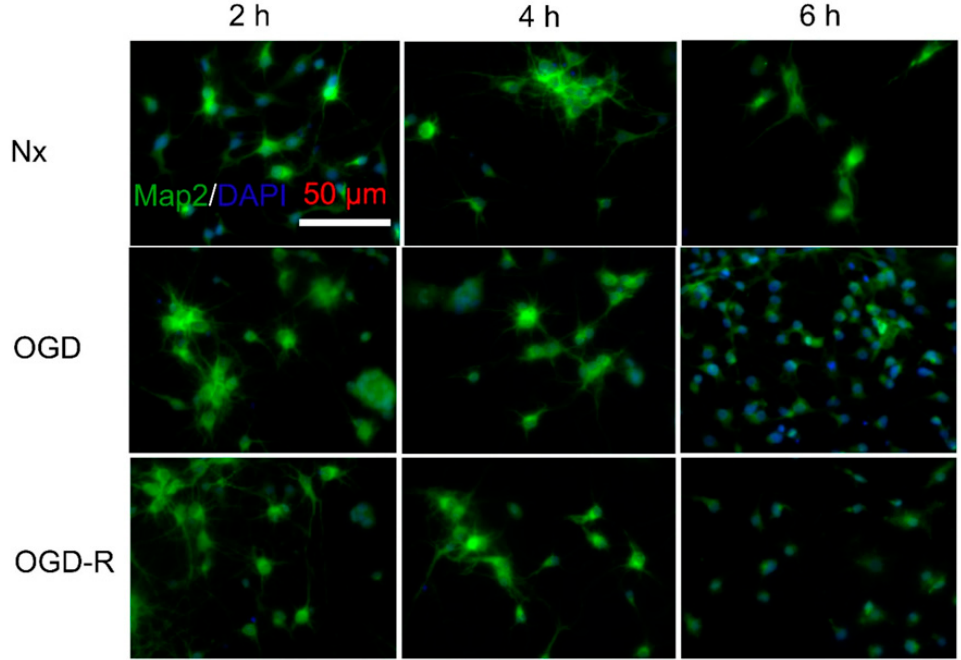
Figure 7. Immunofluorescence images (with MAP2) of primary cortical neurons subjected to oxygen–glucose deprivation (OGD) before and after reperfusion by. Representative double merged (FITC-labelled MAP2 immunofluorescence (green) and DAPI-stained nuclei) revealed control neuron with numerous dendrites; similar neurons were in neurons subjected to 2 and 4 h OGD before and after 24 h reperfusion. Neurons subjected to 6 h OGD, however, displayed neurons without dendrites; and reduced nuclei/microscopic field was found following 24 h